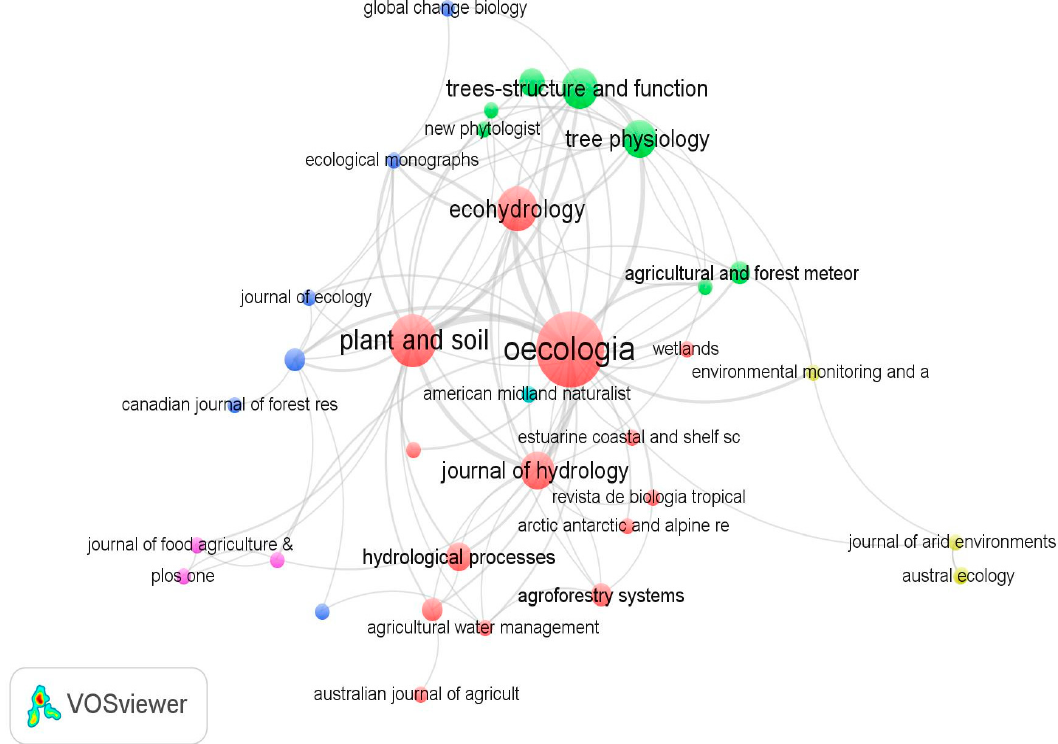
Figure 2. The research journals that the reviewed articles were published in. Note: The size of the nodes / circles indicates the number of articles from each journal. The lines indicate citation connections between journals. Similar colors indicate a single cluster and journals that are highly related are positioned close to each other.